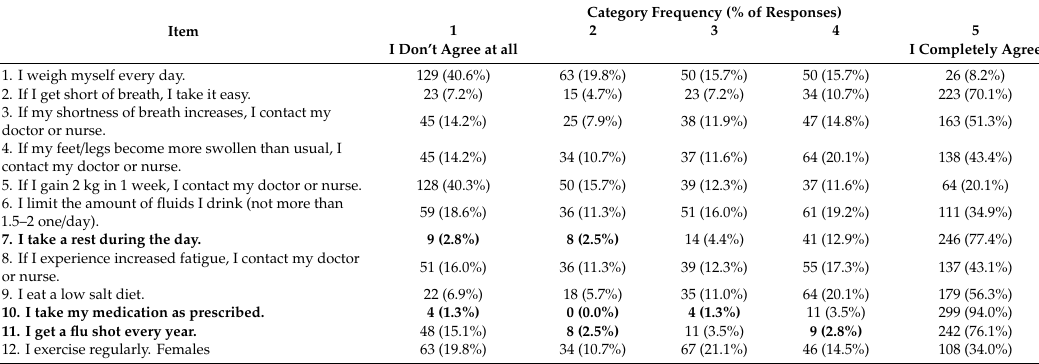
Table 2. Analysis of the rating scale structure of the EHFScBS questionnaire. Items and frequency (%) of answers in each category. Rasch analysis requires categories with ≥ 10 observations. (In bold, categories with < 10 of